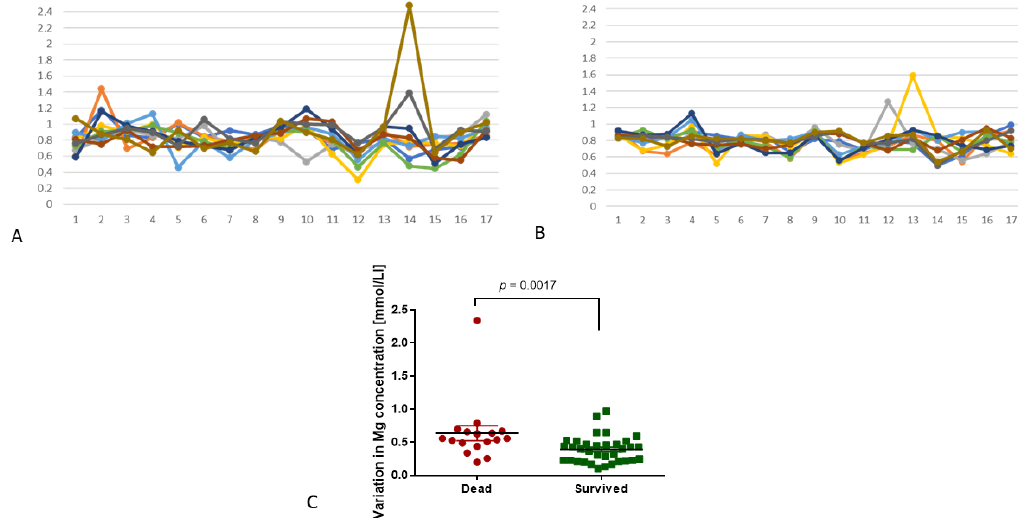
different lower cut-off for reference magnesium concentration in serum.